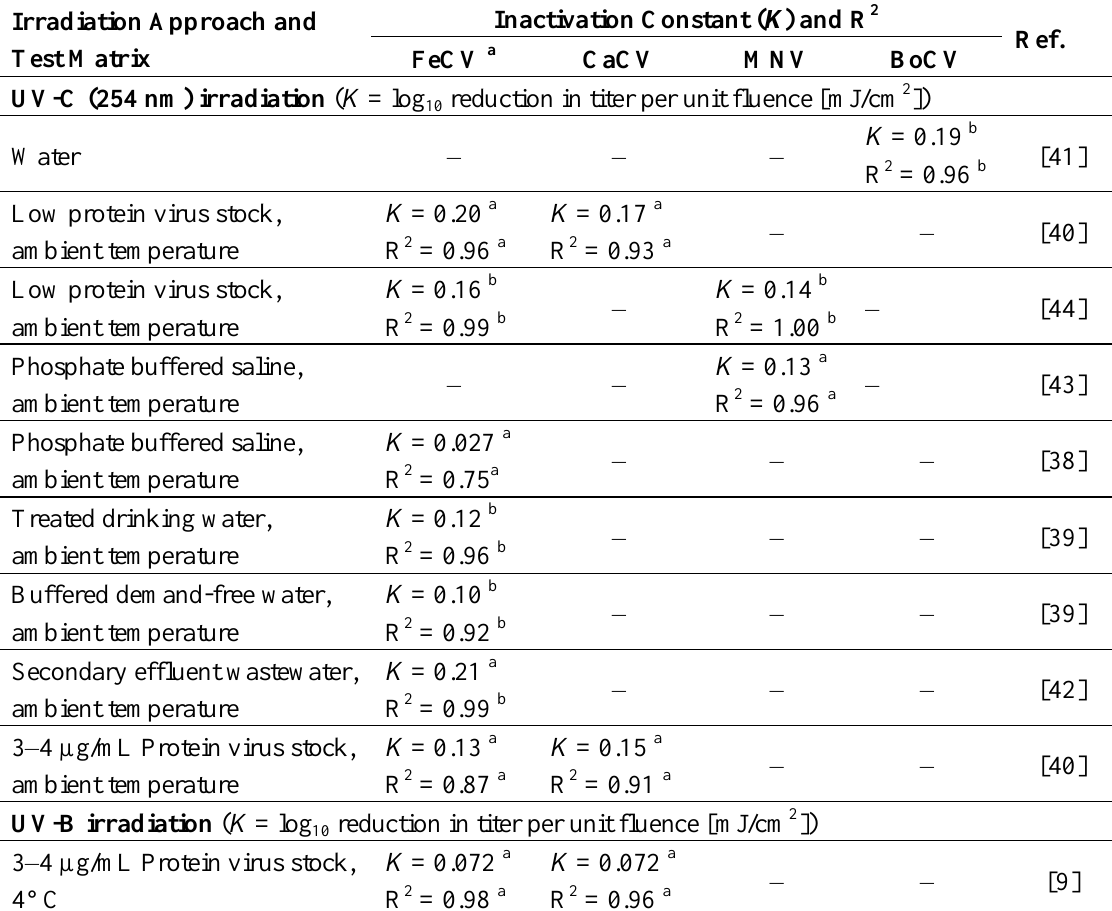
Table 2. Inactivation constants for UV